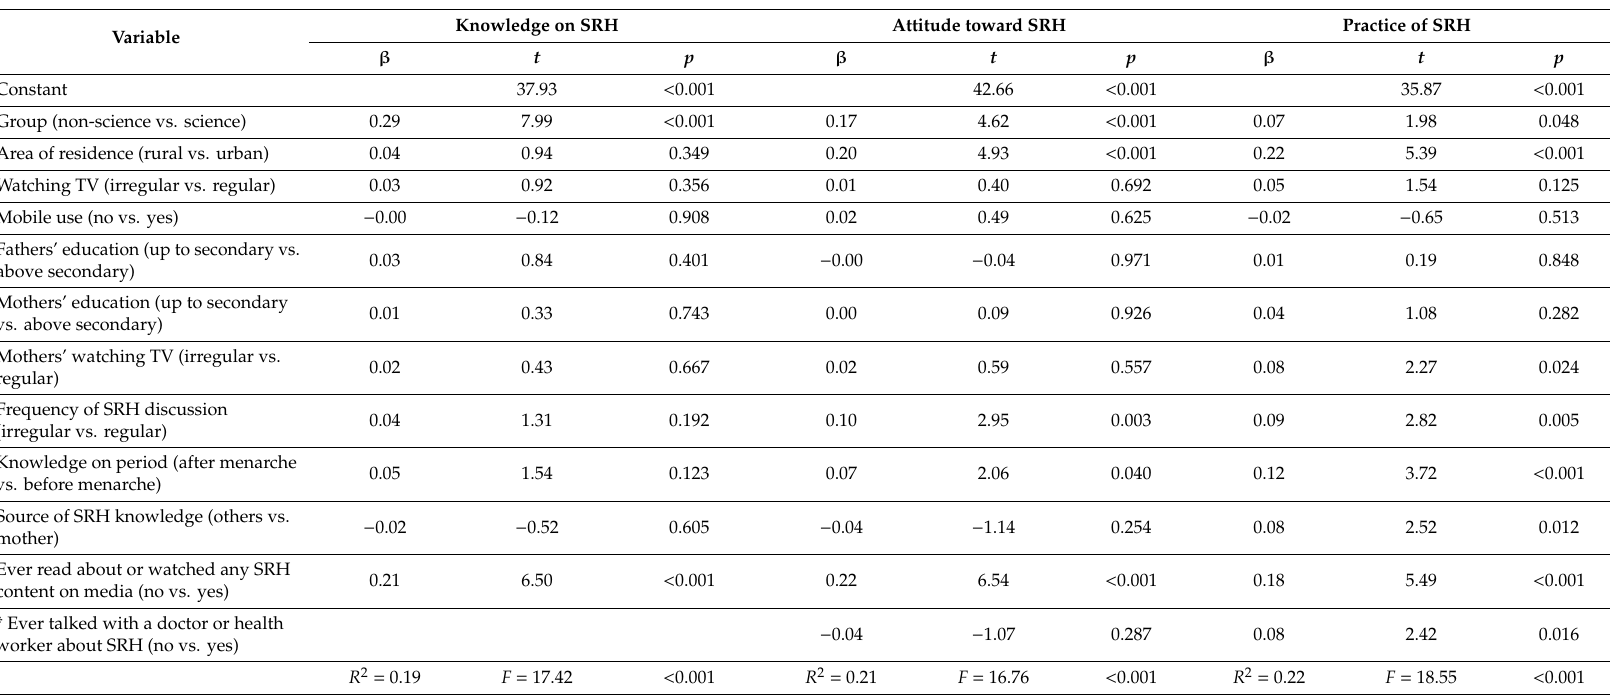
Table 5. Factors influencing SRH-related knowledge, attitude, and practice of older adolescent girls. Knowledge on SRH Attitude toward SRH Practice of Variable